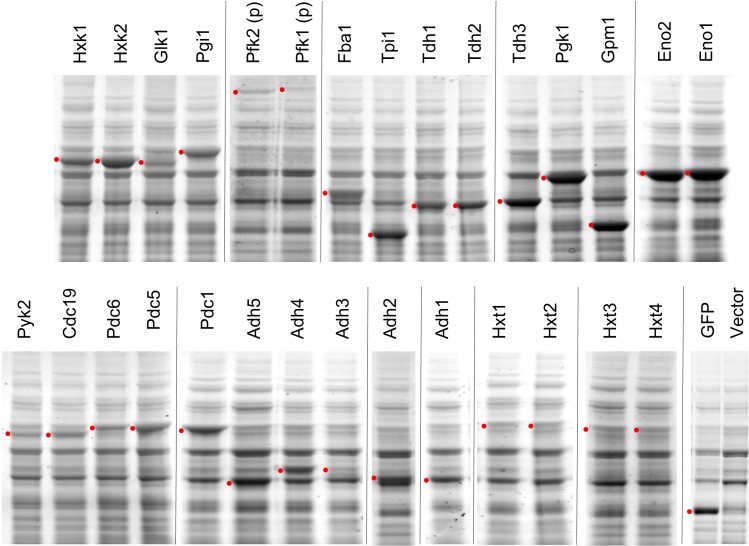
SDS-PAGE-separated total cellular proteins of the cells overexpressing glycolytic proteins.Proteins were analyzed in low-copy conditions. Red dots indicate the expected size of the target proteins. The TDH3 promoter was used for the expression of all genes except where (p) indicates the use of the PYK1 promoter.